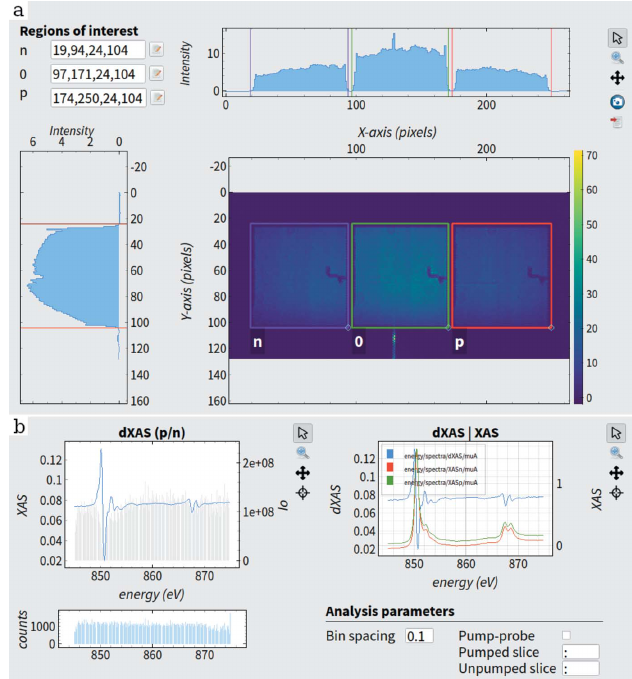
Figure 8 ( a ) Dark-corrected single-train image of the DSSC sensor in the Karabo GUI. The overlayed regions of interest define the intensity of the imaged beams and can be modified using the EXtra-metro parameter fields or by user interaction in the GUI. The projections along x and y axes are also plotted as guides for optimal zone plate alignment. ( b ) XAS spectra of the three ratios after an energy scan displayed in the Karabo GUI. The panel also contains the analysis parameter fields that can be changed during run time.